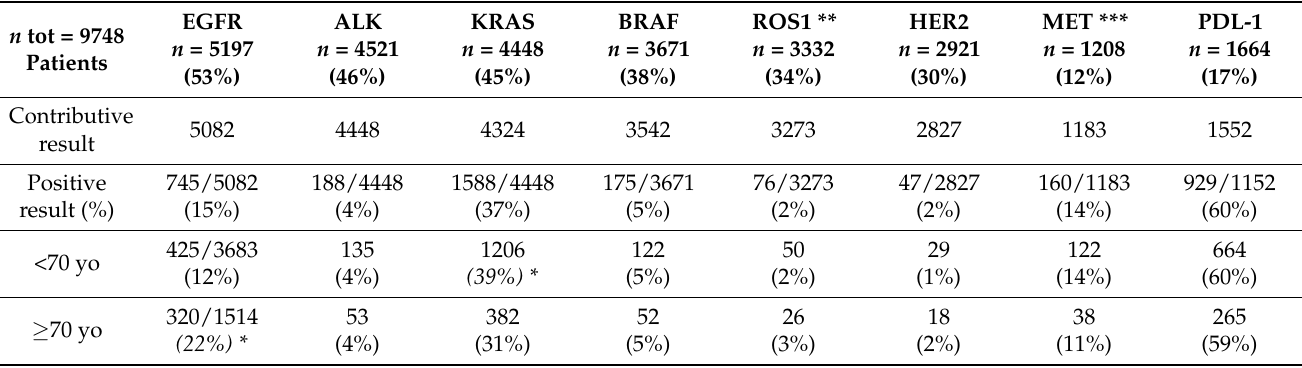
Table 2. Proportion of molecular alteration in each age